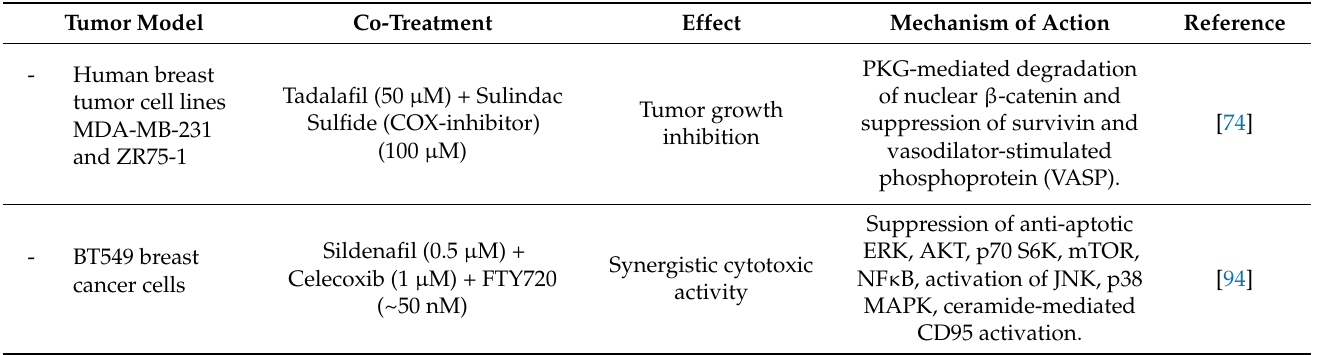
Table 1. The synergistic cytotoxic activity of PDE5-I in combination with other drugs in in vitro and in vivo models of breast